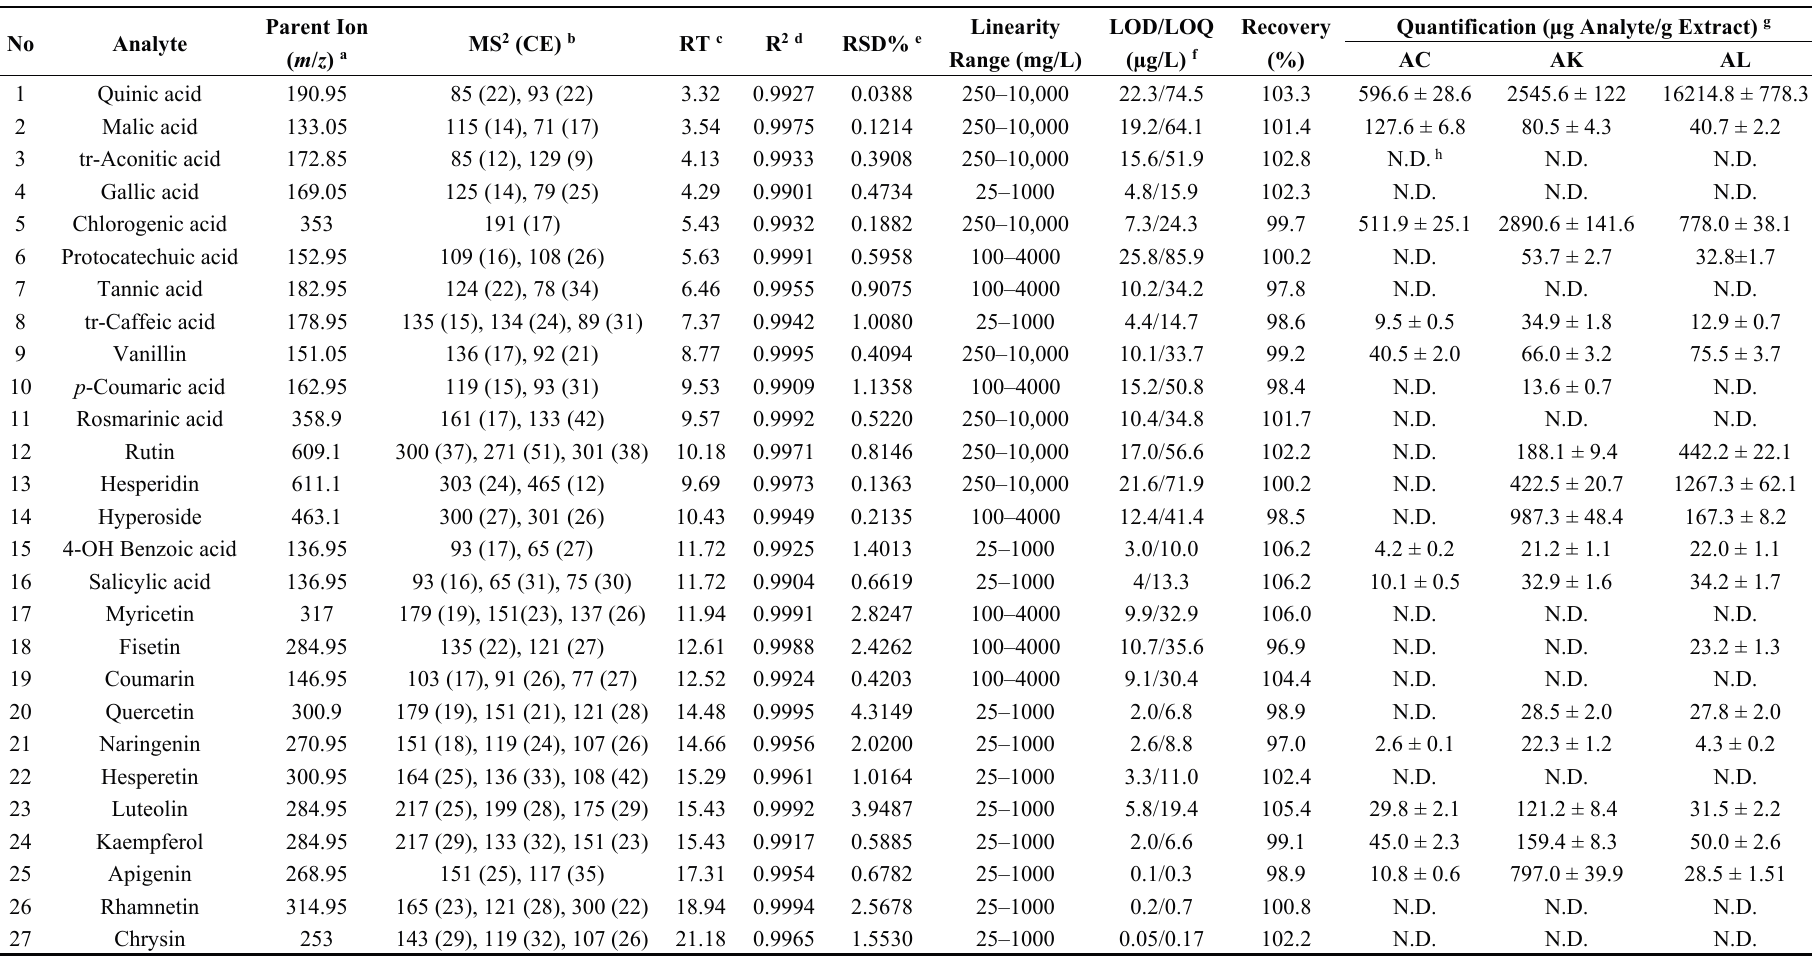
Table 1. Analytical parameters of LC-MS/MS method, and identification and quantification of phenolic compounds in AC, AK and